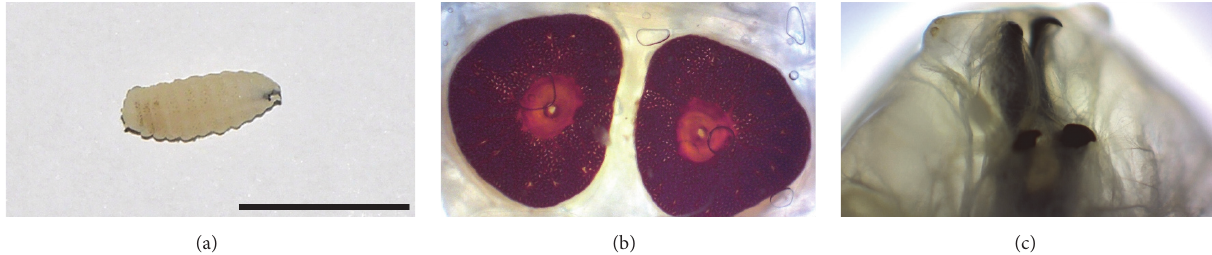
Figure 1: (a) Dorsal view of the O. ovis larva recovered by the patient (Bar = 10mm). (b) Dark posterior spiracles with a flat side medially and respiratory holes arranged radially (40x). (c) Anterior hooks (40x).